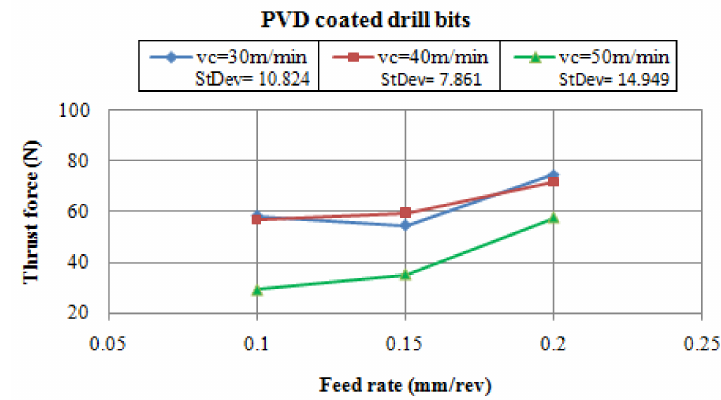
Figure 6. Thrust force variation with feed rates at different cutting speeds when using PVD-coated drill bits.